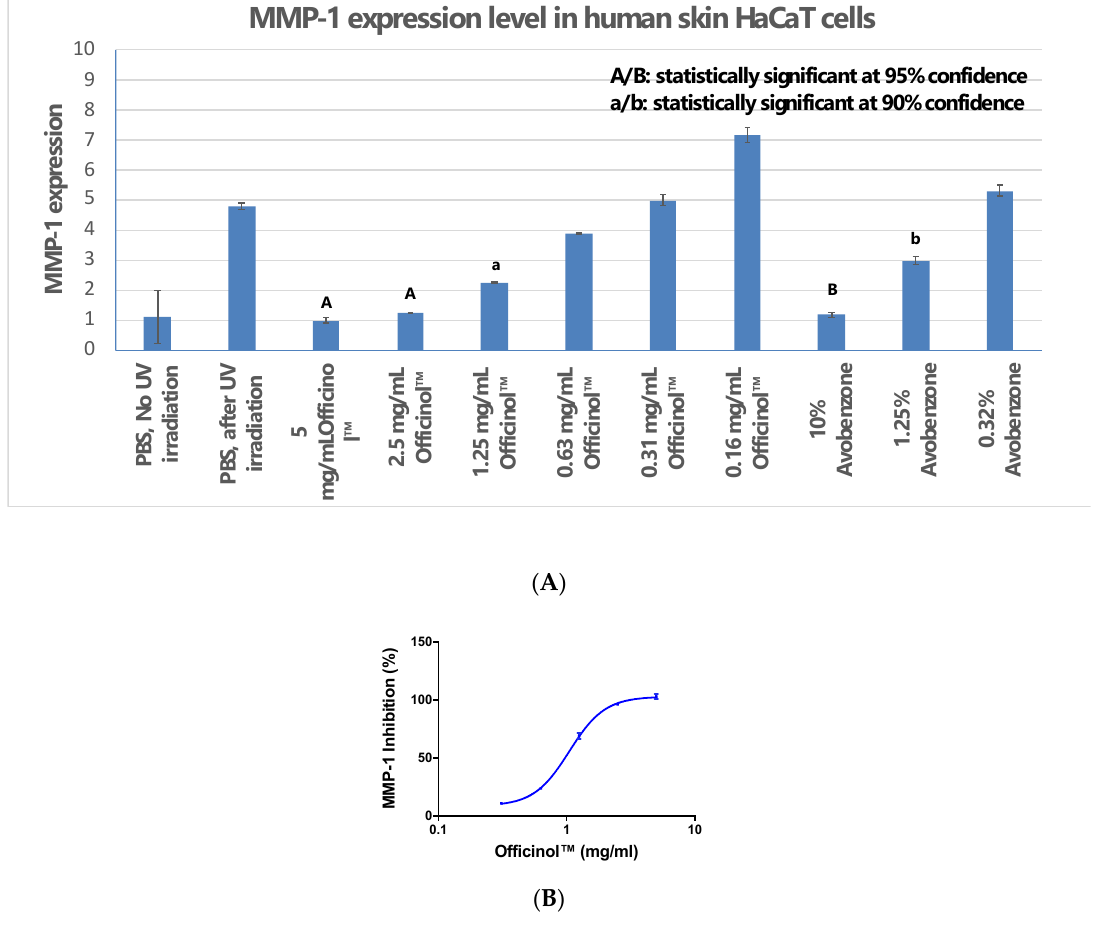
Figure 3. Officinol™ protects human skin HaCaT cells from UV irradiation damage, possibly through Figure 3. O ffi cinol ™ protects human skin HaCaT cells from UV irradiation damage, possibly through MMP-1 inhibition as one of the function pathways. ( A ) Effect of UV irradiation on MMP-1 level in MMP-1 inhibition as one of the function pathways. ( A ) E ff ect of UV irradiation on MMP-1 level in HaCaT HaCaT cells, and the inhibition of MMP-1 by treatments of Officinol™ and avobenzone; ( B ) Dose- cells, and the inhibition of MMP-1 by treatments of O ffi cinol ™ and avobenzone; ( B ) Dose-dependent dependent MMP-1 inhibition effect by treatment of Officinol™ in HaCaT cells under UV irradiation. MMP-1 inhibition e ff ect by treatment of O ffi cinol ™ in HaCaT cells under UV irradiation. Graph on a Graph on a logarithmic scale. logarithmic